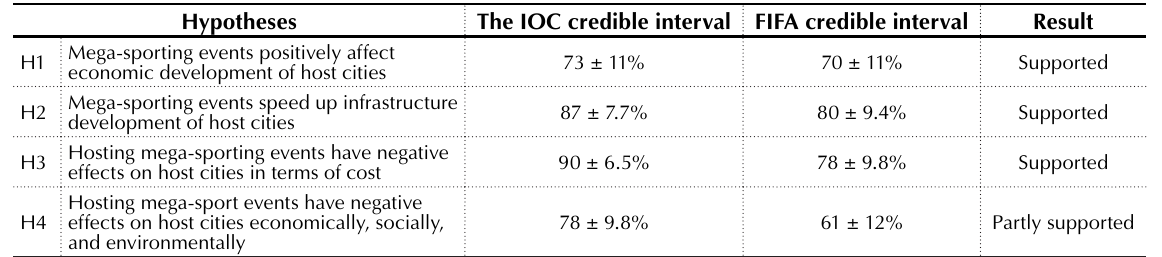
Table 4. Results of hypotheses